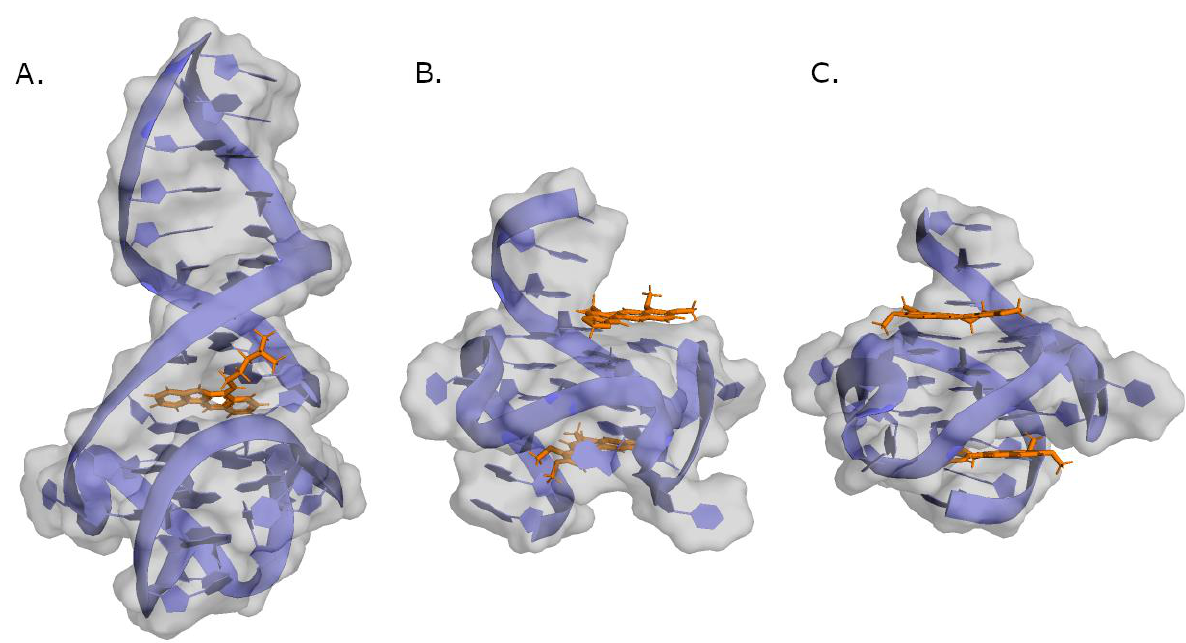
Figure 6. Representation of different compounds (colored sticks) in complex with a DNA structure (represented as cartoon and transparent surface). ( A ) Indoloquinoline 4 in complex with c- MYC G4 (PDB ID: 7PNG). ( B ) Conformer B of berberine in complex with c-MYC G4 (PDB ID: 7N7E). ( C ) Conformer A of berberine in complex with c-MYC G4 (PDB ID: 7N7D).